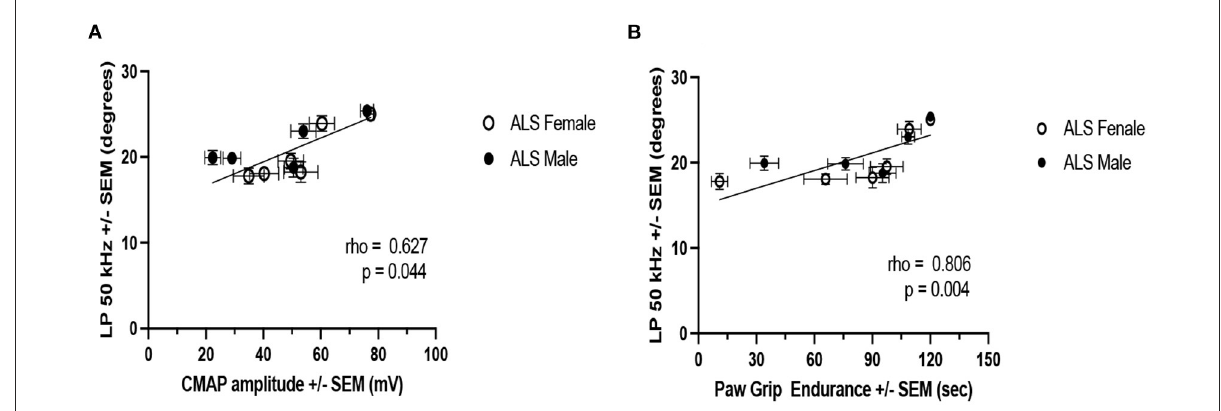
FIGURE6 Correlation of LP 50kHz with PGE and CMAP amplitude. (A) PGE. (B) CMAP amplitude. For this analysis, weekly data from all ALS animals are averaged by sex.